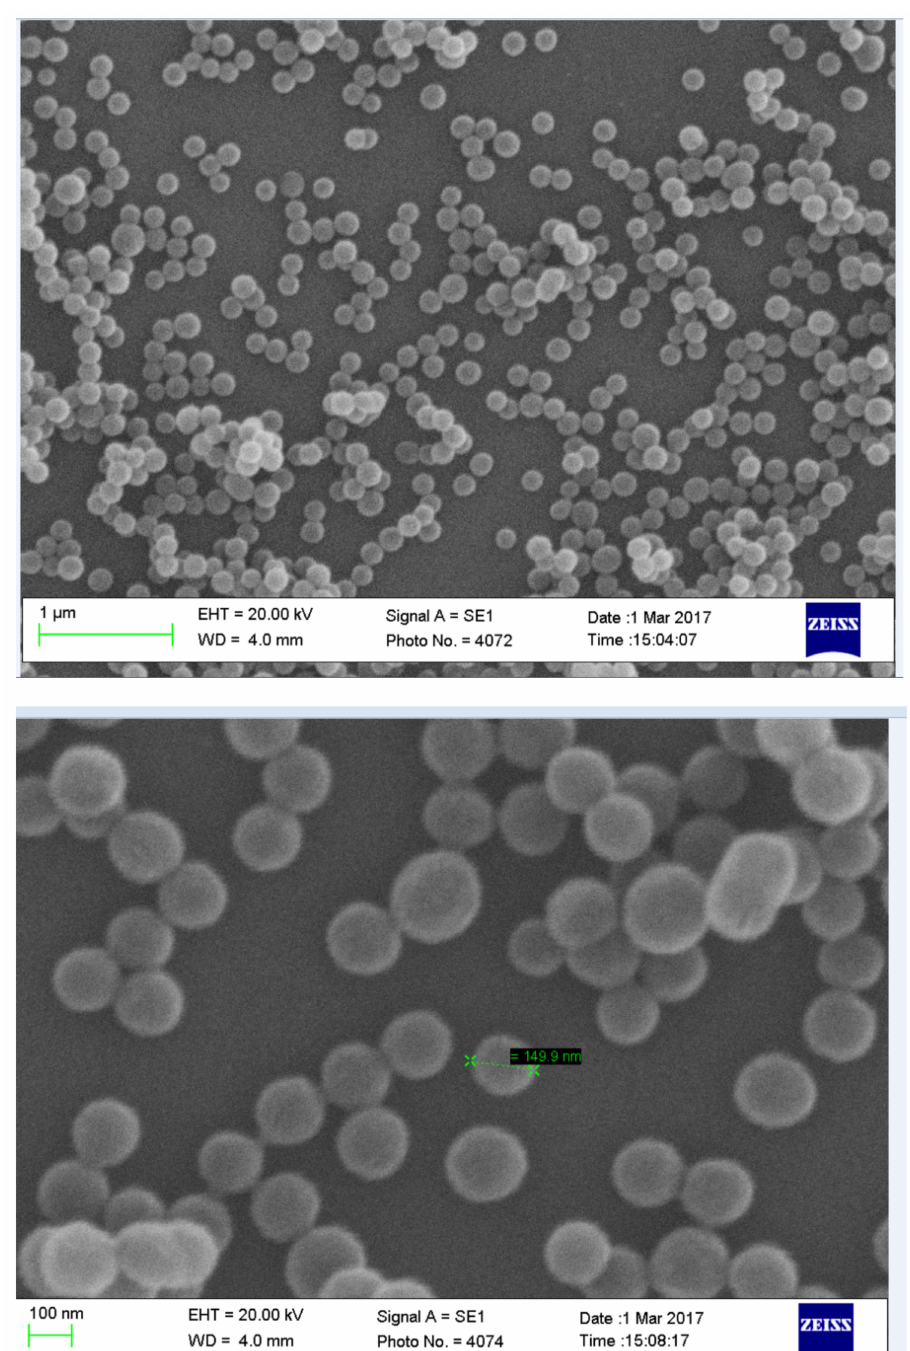
Figure 13. Images showing SEM image non-drug-loaded chitosan nanoparticles formulated with a concentration of 0.4 mg/mL NaTPP via ionotropic